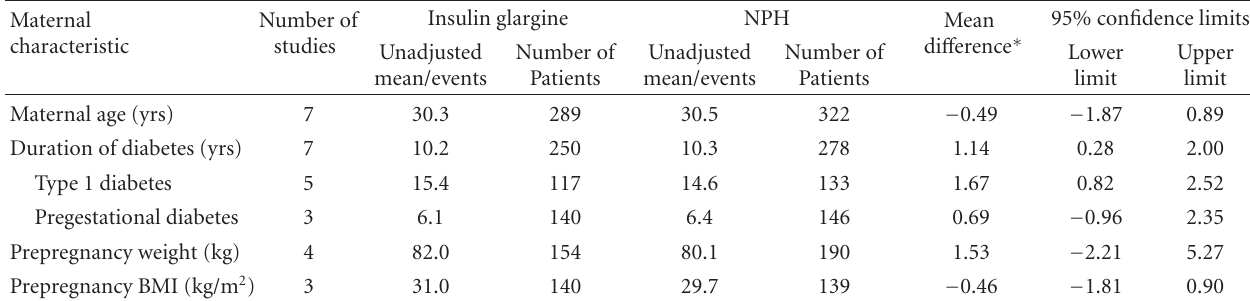
Table 2: Baseline maternal characteristics of pregnant women using insulin glargine versus NPH among the studies selected for meta- analysis.